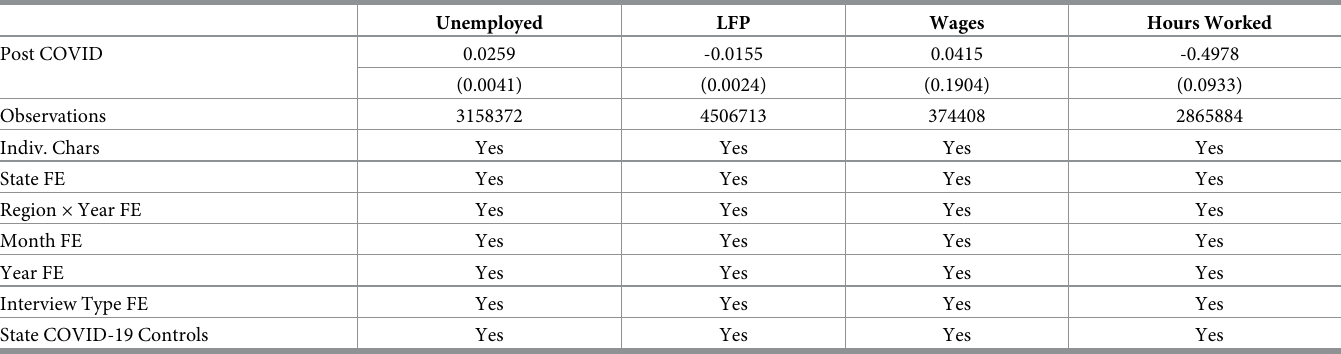
Table 6. The impacts of COVID-19: